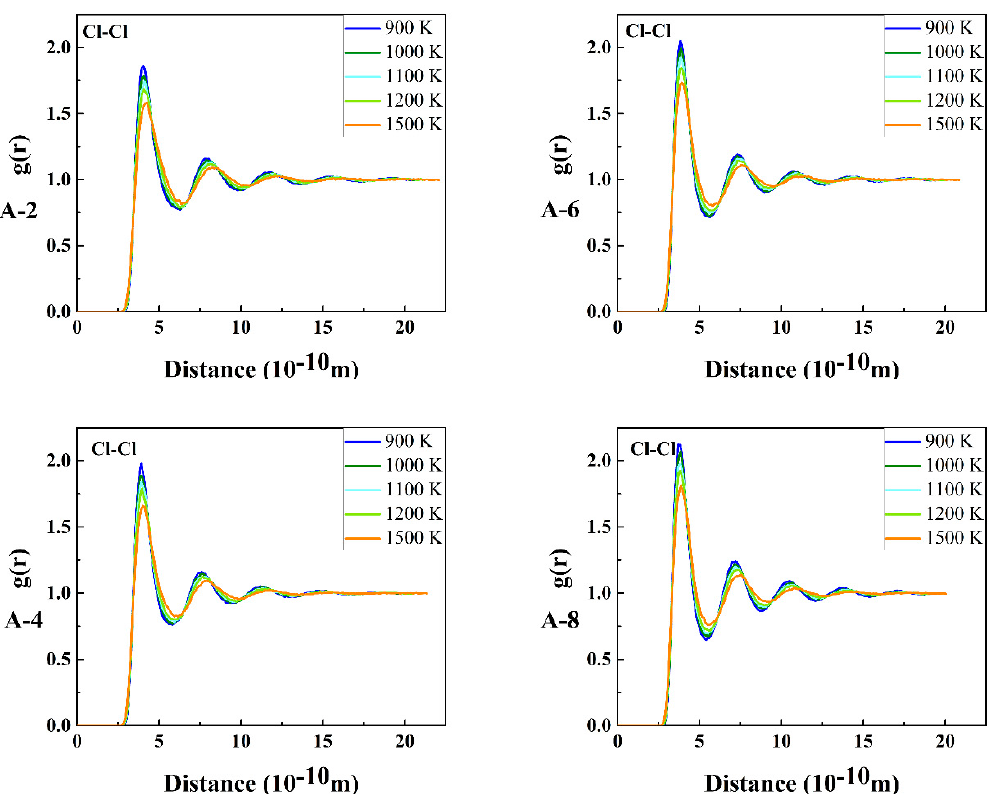
Figure A4. PDFs of Cl-Cl pairs in the four ternary systems (A-2, A-4, A-6, and A-8) at 900 K, 1000 K, 1100 K, 1200 K, and 1500 K.